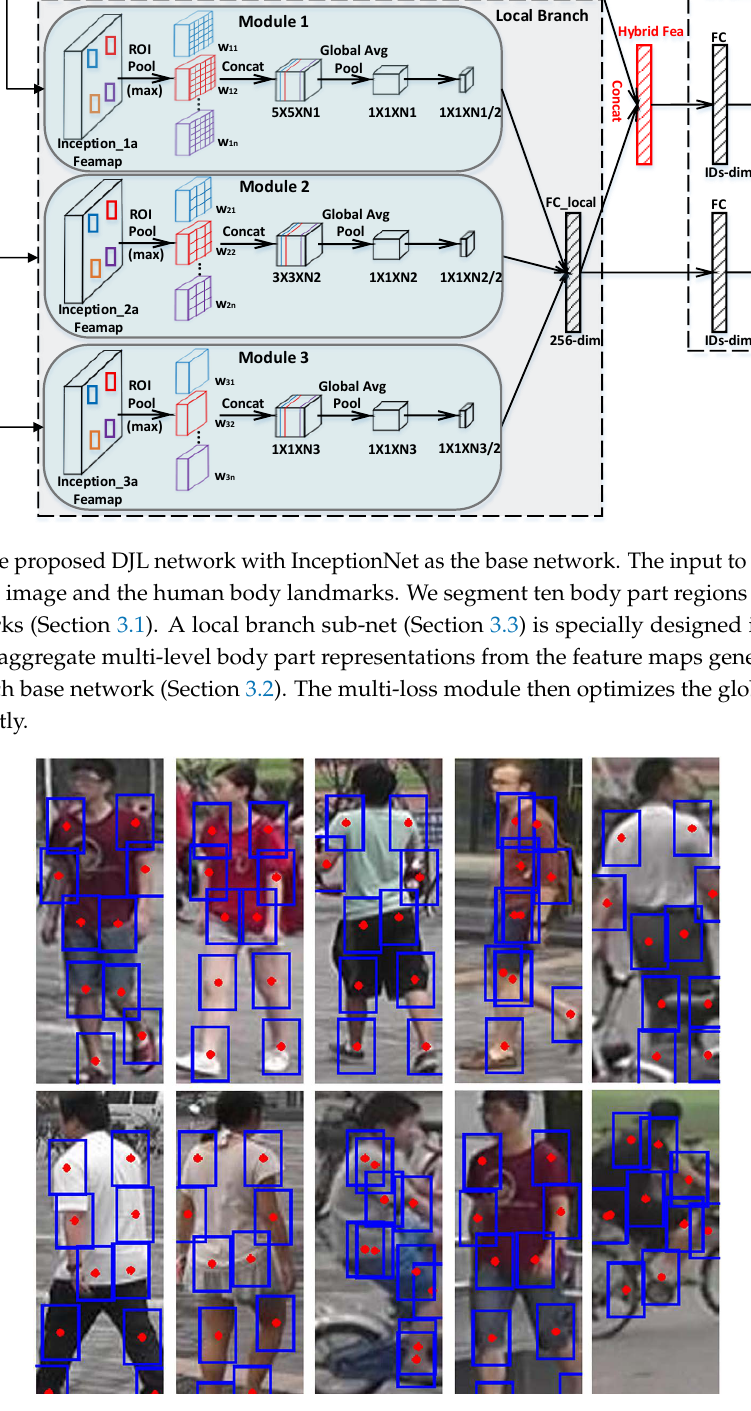
Figure 4. Examples of the segmented ten body parts used in our DJL